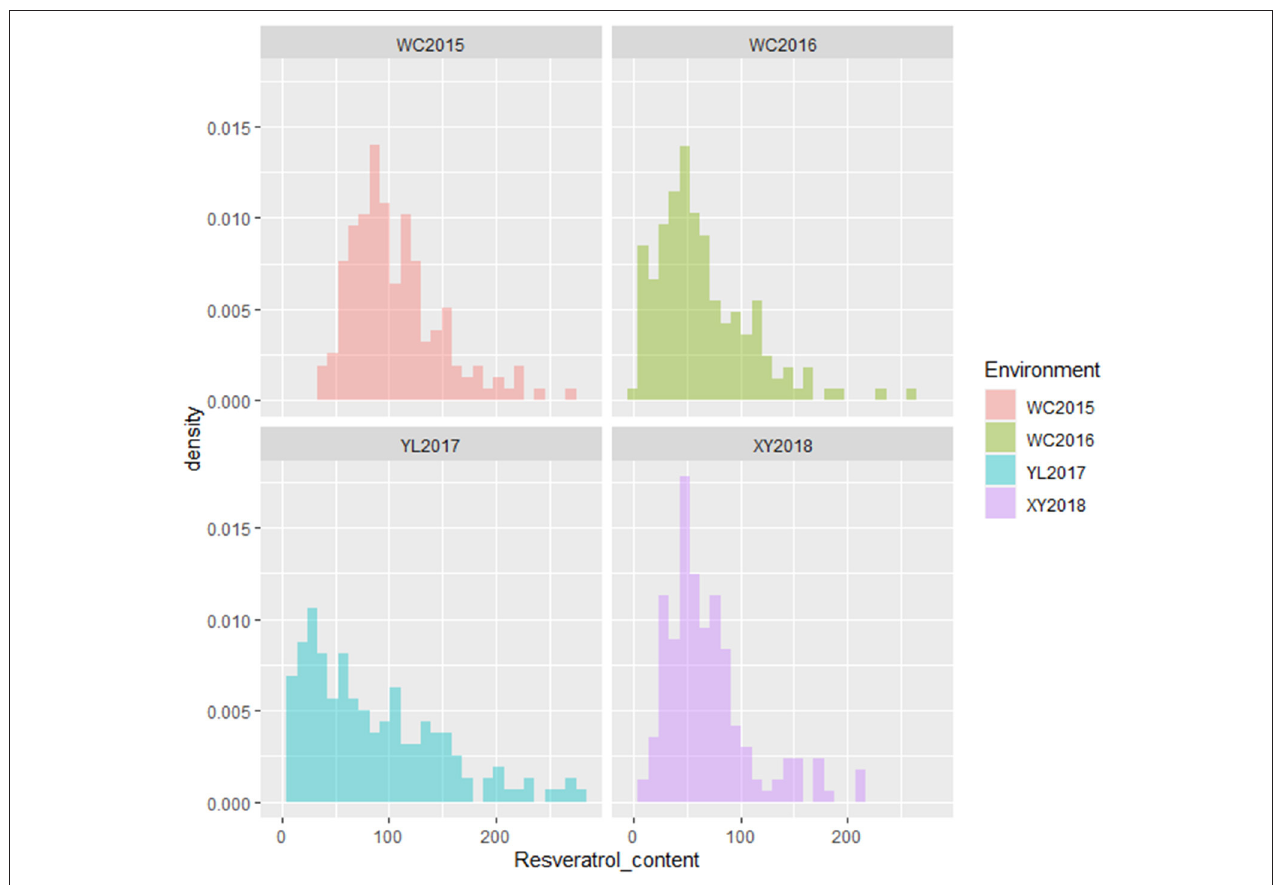
FIGURE 1 | Phenotypic distribution of resveratrol contents in the RIL population across environments. The y -axis represented density, while the x -axis represented values of resveratrol contents ( µ g/kg).